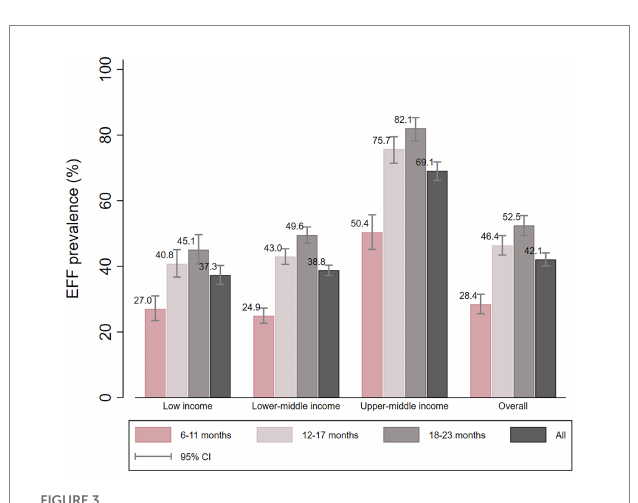
FIGURE 3 EFF prevalence according to country income and child age